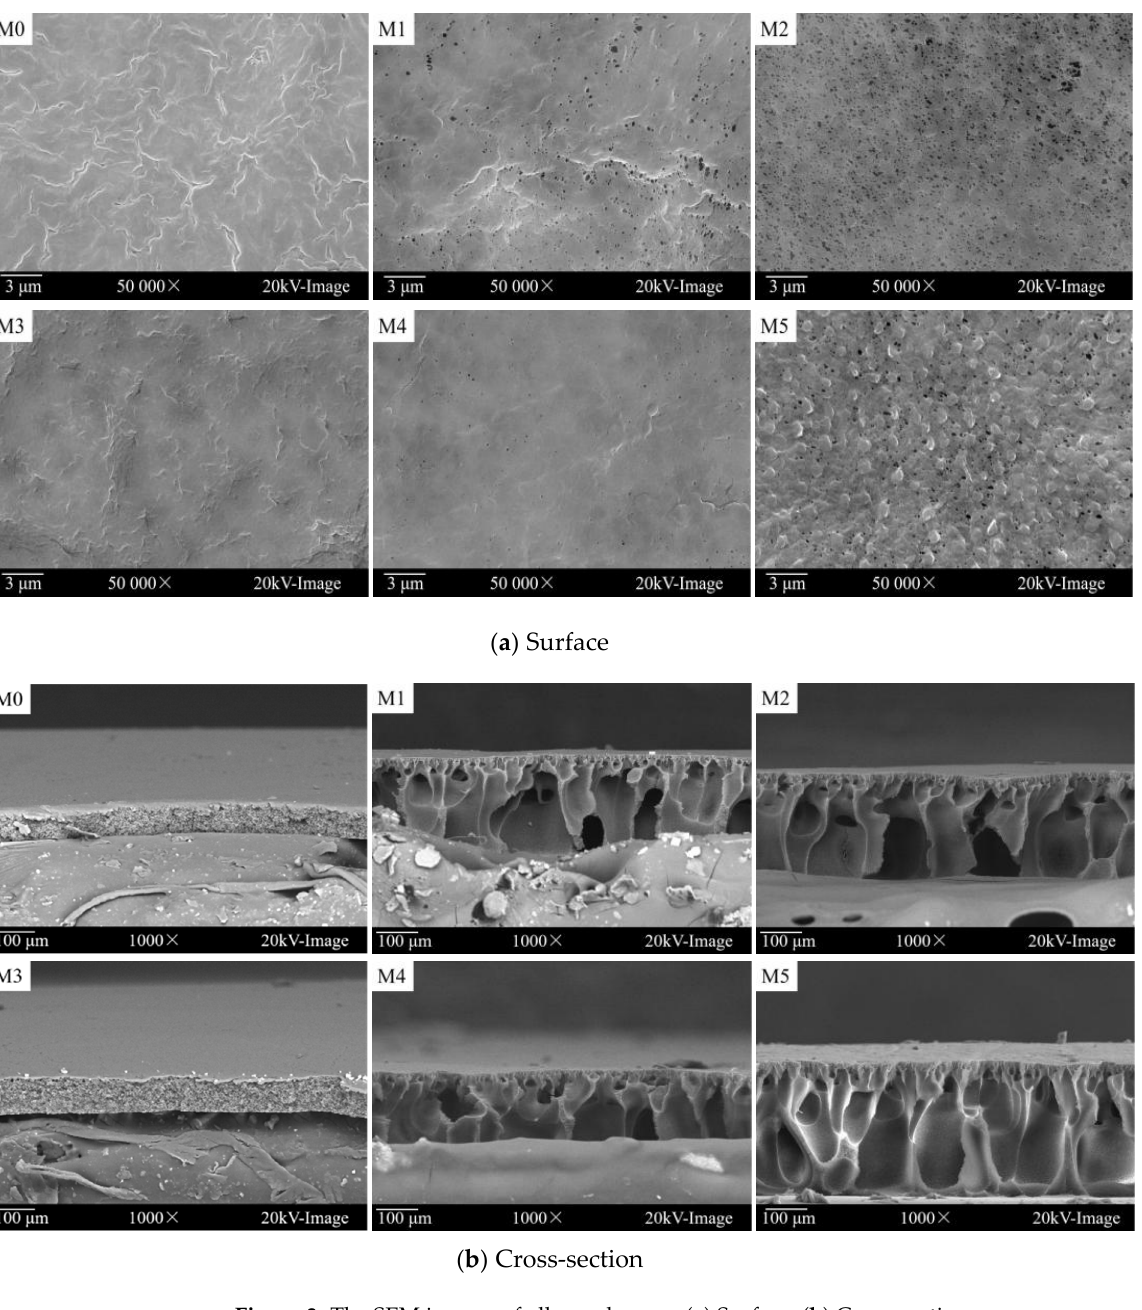
Figure 3. The SEM images of all membranes. ( a ) Surface; ( b ) Cross-section.